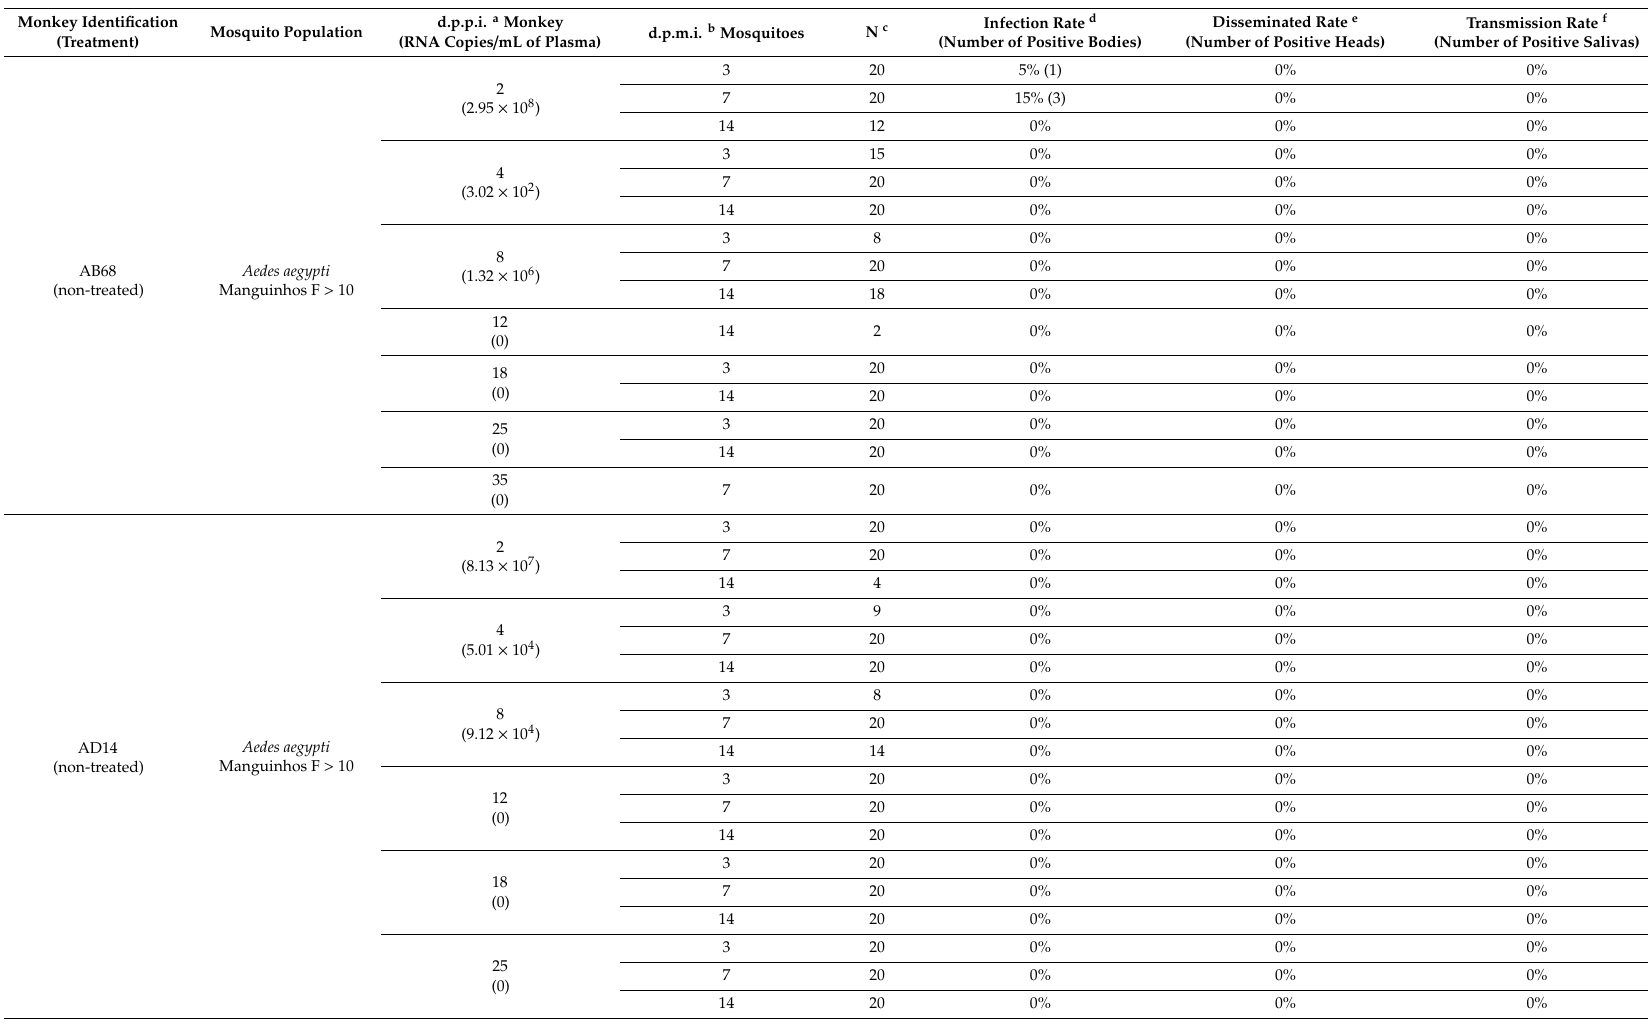
Table 1. Infection, Dissemination and Transmission Rates of Aedes aegypti mosquitoes blood-fed on Zika virus (ZIKV) inoculated pregnant rhesus monkeys. Monkey Identification